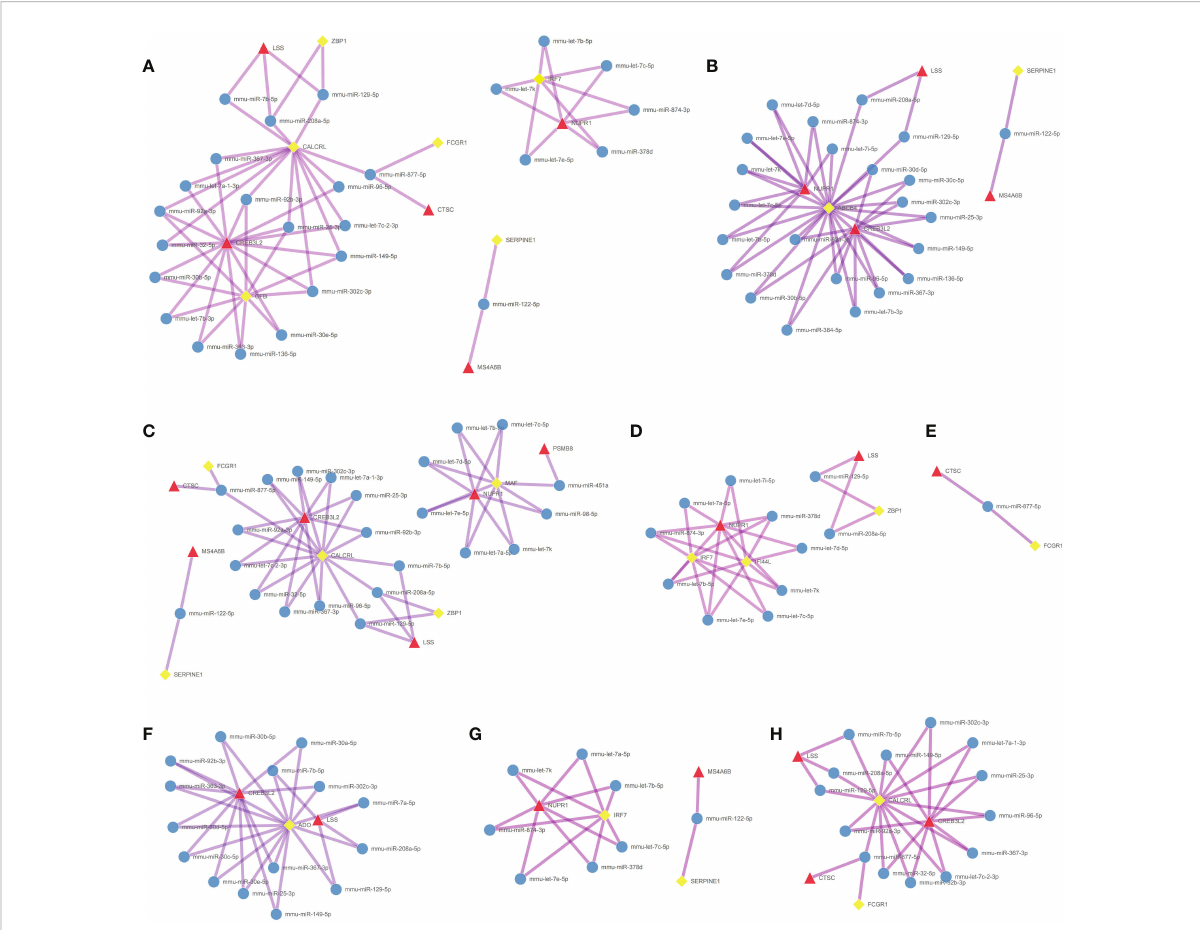
FIGURE 6 Construction of the ceRNA networks. DEmRNA-miRNA-DElncRNA networks of (A) positive regulation of defense response, (B) cellular response to interferon-gamma, (C) positive regulation of in fl ammatory response, (D) response to virus, (E) antigen processing and presentation, (F) metabolism of amino acids and derivatives, (G) regulation of cytokine production, and (H) receptor-mediated endocytosis. (Blue Ball: miRNA; Red Triangle: lncRNA; Yellow Square: